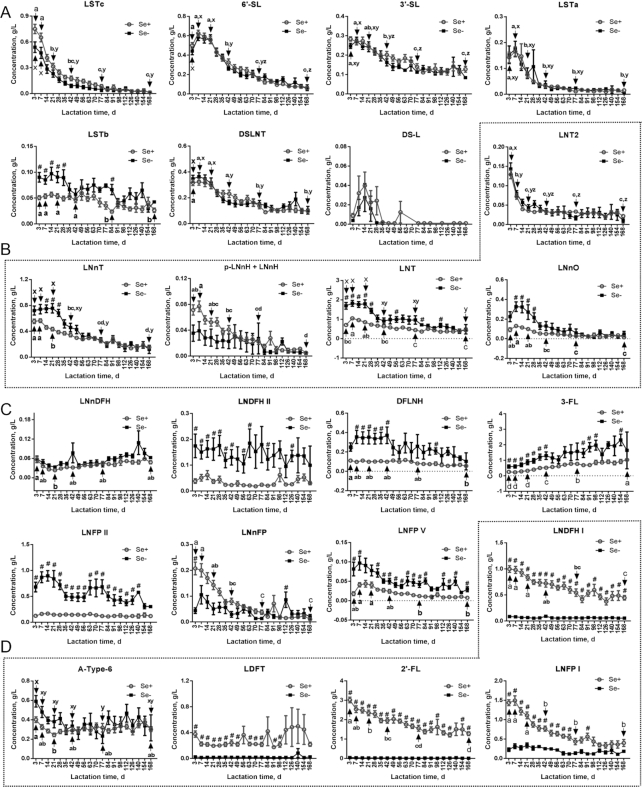
Dynamic changes of 24 HMOs in milk of Se+ and Se− mothers during lactation. Comparison of dynamic changes of (A) acidic, (B) nonfucosylated, (C) α-1-3/4-fucosylated, and (D) α-1-2-fucosylated HMOs in Se+ and Se− mothers during lactation. Acidic HMOs include LSTc, 6′-SL, 3′-SL, LSTa, LSTb, DSLNT, and DS-L. Nonfucosylated HMOs include LNT2, LNnT, p-LNnH + LNnH, LNT, and LNnO. α-1-3/4-fucosylated HMOs include LNnDFH, LNDFH II, DFLNH, 3-FL, LNFP II, LNnFP, and LNFP V. α-1-2-fucosylated HMOs include LNDFH I, A-Type-6, LDFT, 2′-FL, and LNFP I. All values are means ± SEMs. “a,” “b,” … and “x,” “y,” … indicate differences among different time points in Se+ and Se− mothers, respectively. # indicates statistical significance between Se+ and Se− mothers at the same lactation time. P < 0.05 was considered significant. A-Type-6, Blood Group A tetrasaccharide; DFLNH, difucosyllacto-N-hexaose; DS-L, disialyl lactose; DSLNT, disialyllacto-N-tetraose; HMO, human milk oligosaccharide; LDFT, lactodifucotetraose; LNDFH, lacto-N-difucohexaose; LNFP, lacto-N-fucopentaose; LNnDFH, lacto-N-neodifucohexaose; LNnFP, lacto-N-neofucopentaose; LNnH, lacto-N-neohexaose; LNnO, lacto-N-neooctaose; LNnT, lacto-N-neotetraose; LNT, lacto-N-tetraose; LNT2, lacto-N-triose; LST, LS-tetrasaccharide; p-LNnH, p-lacto-N-neohexaose; Se+, secretor; Se−, nonsecretor; 2′-FL, 2′-fucosyllactose; 3-FL, 3-fucosyllactose; 3′-SL, 3′-sialyllactose; 6′-SL, 6′-sialyllactose.